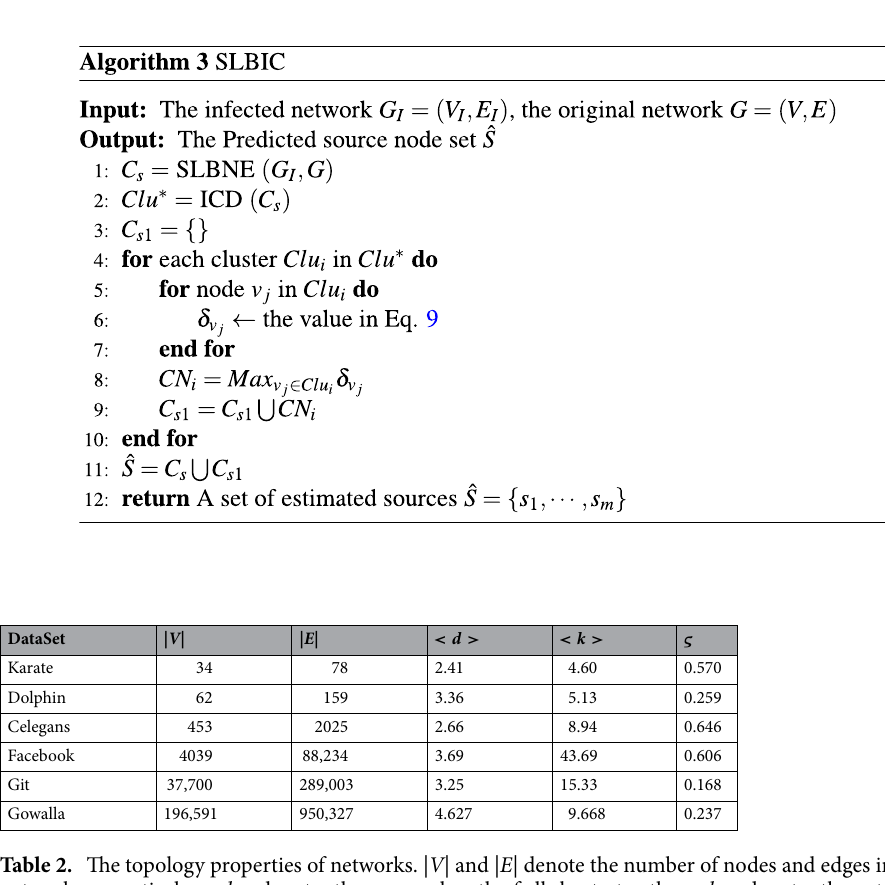
Table 2. The topology properties of networks. | V | and | E | denote the number of nodes and edges in the network, respectively. < d > denotes the average length of all shortest paths. < k > denotes the network average. ς denotes the average clustering coefficient of the